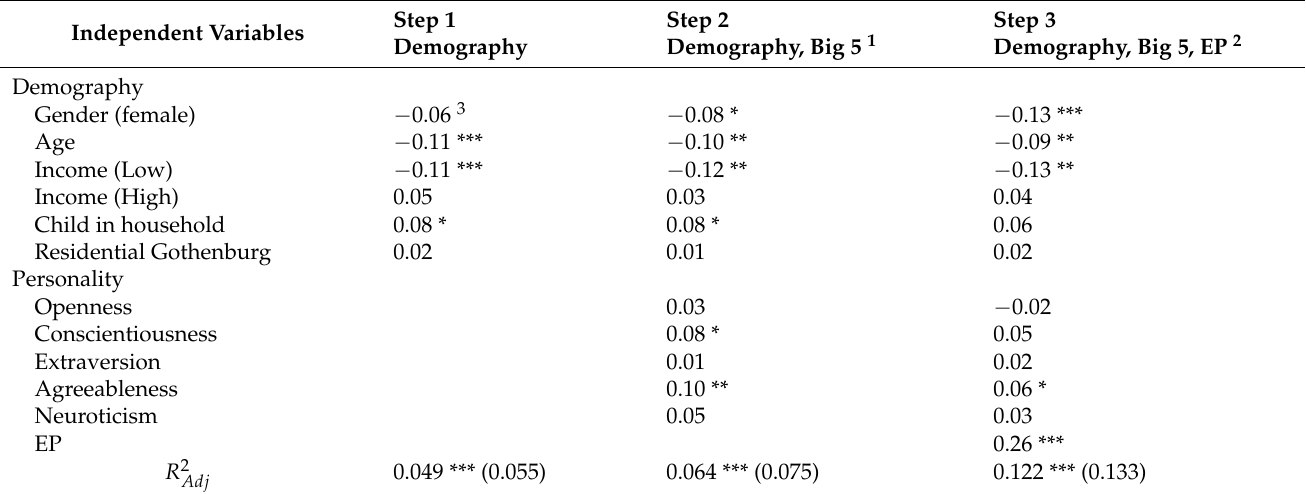
Table 5. Hierarchical regression models exploring how demography and personality predict cycling ( N =